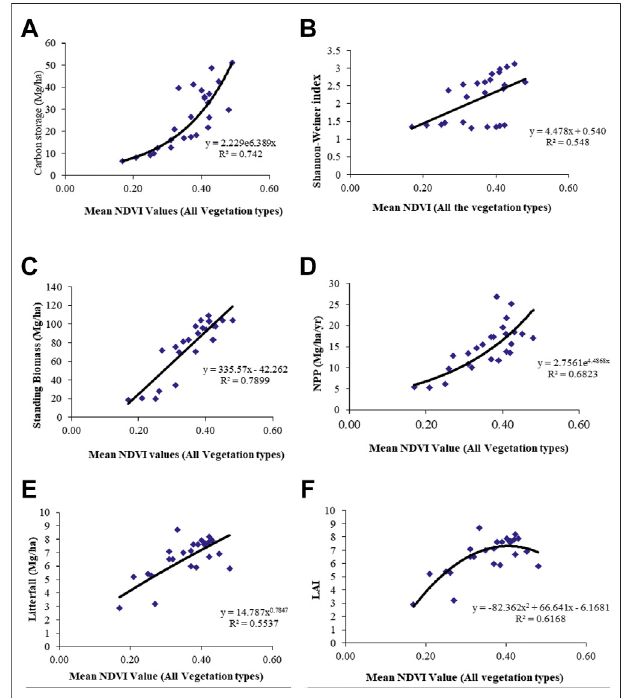
FIGURE 4 | (A) Exponential relationship among NDVI and Carbon storage; (B) Relationship between NDVI and Shannon- Weiner Index; (C) Relationship between NDVI and Biomass of dry tropical forests; (D) Exponential relationship between NDVI and Net primary productivity; (E) RelationshipbetweenNDVIandLitterfall; (F) Exponentialrelationshipbetween NDVI and Leaf Area Index of dry tropical forests of